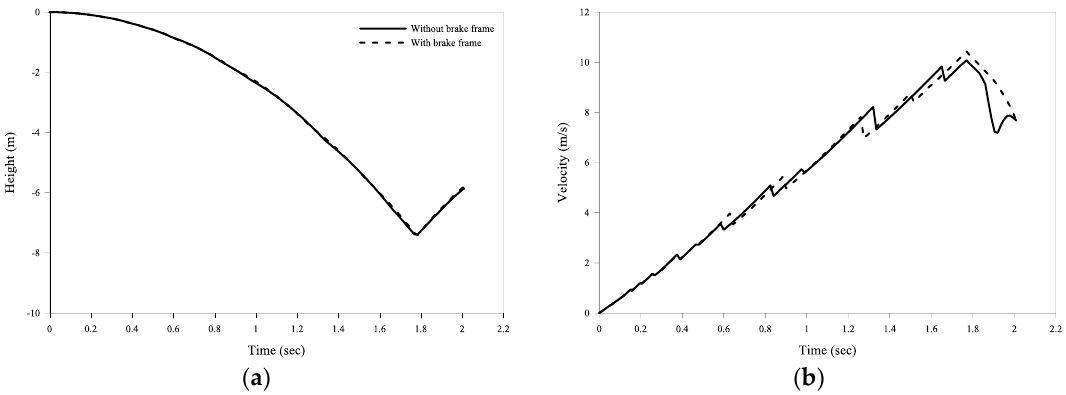
Figure 11. Height and velocity of impact block while rolling, ( a ) height of impact block; and ( b ) velocity of impact block.